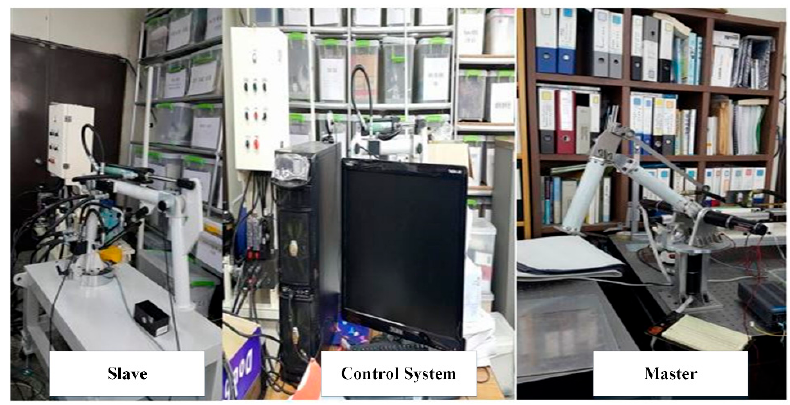
Figure 8. Experimental setup.